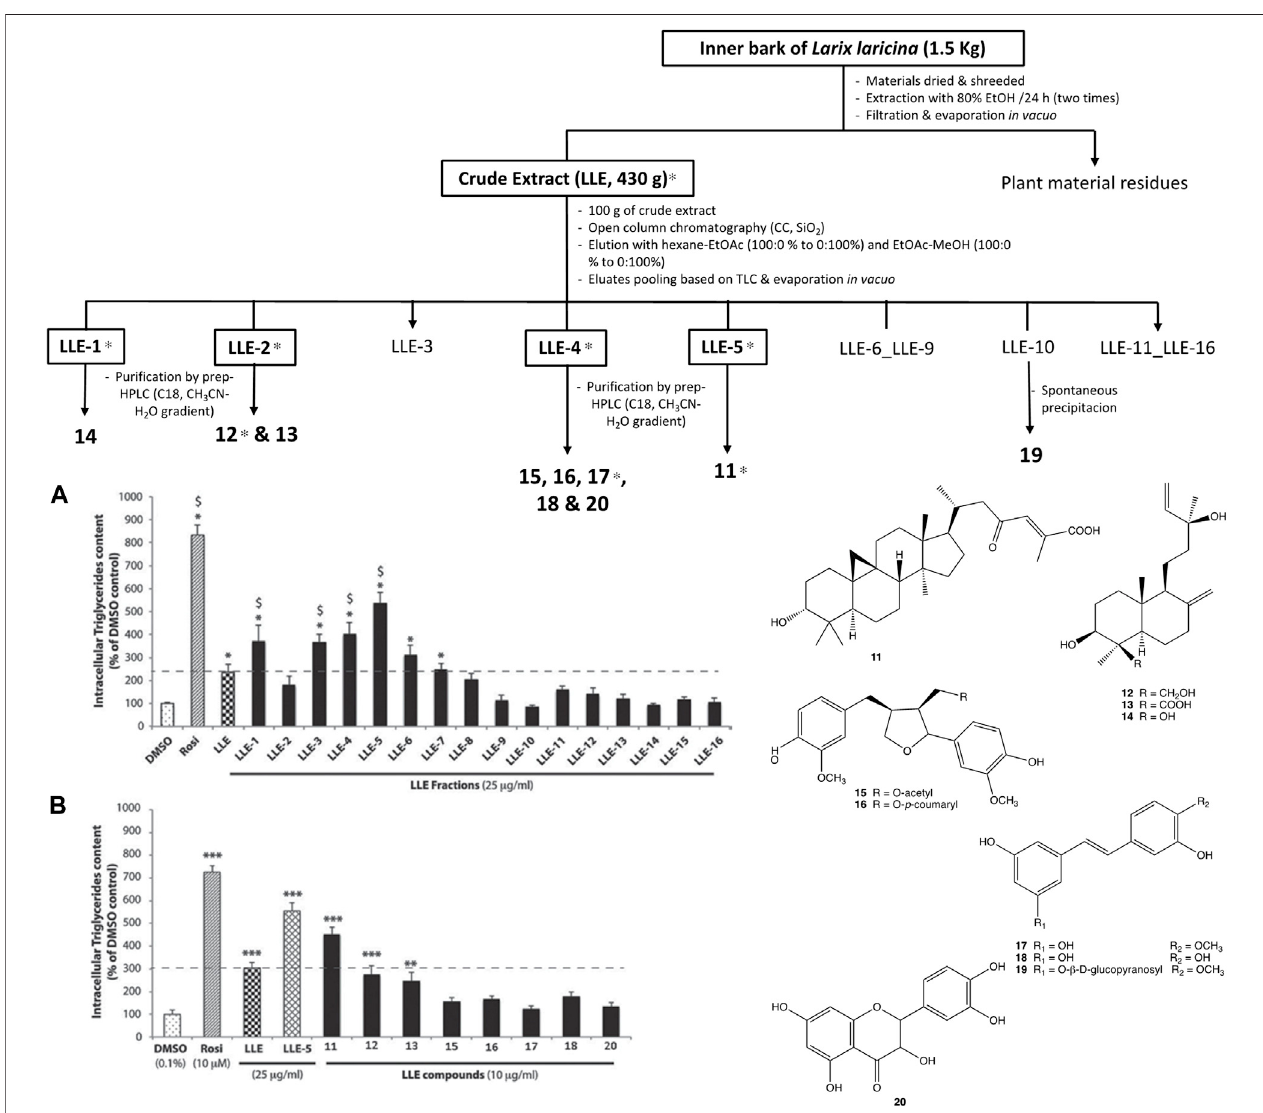
FIGURE 4 | Classic bioassay guided fractionation of Larix larcina (Tamarack or larch) in an adipogenic activity assay leading to identi fi cation of a novel cycloartane triterpenoidnamedAwashishicacid(23-oxo-3-hydroxycycloart-24-en-26-oicacid,11).FigureadaptedwithpermissiontousedatafromShangetal.,2012.Adipogenic constituents from the bark of Larix laricina du roi (K. koch; Pinaceae), an important medicinal plant used traditionally by the Cree of eeyou istchee (Quebec, Canada) for the treatment of type 2 diabetes symptoms. J. Ethnopharmacol.141:1051-7.